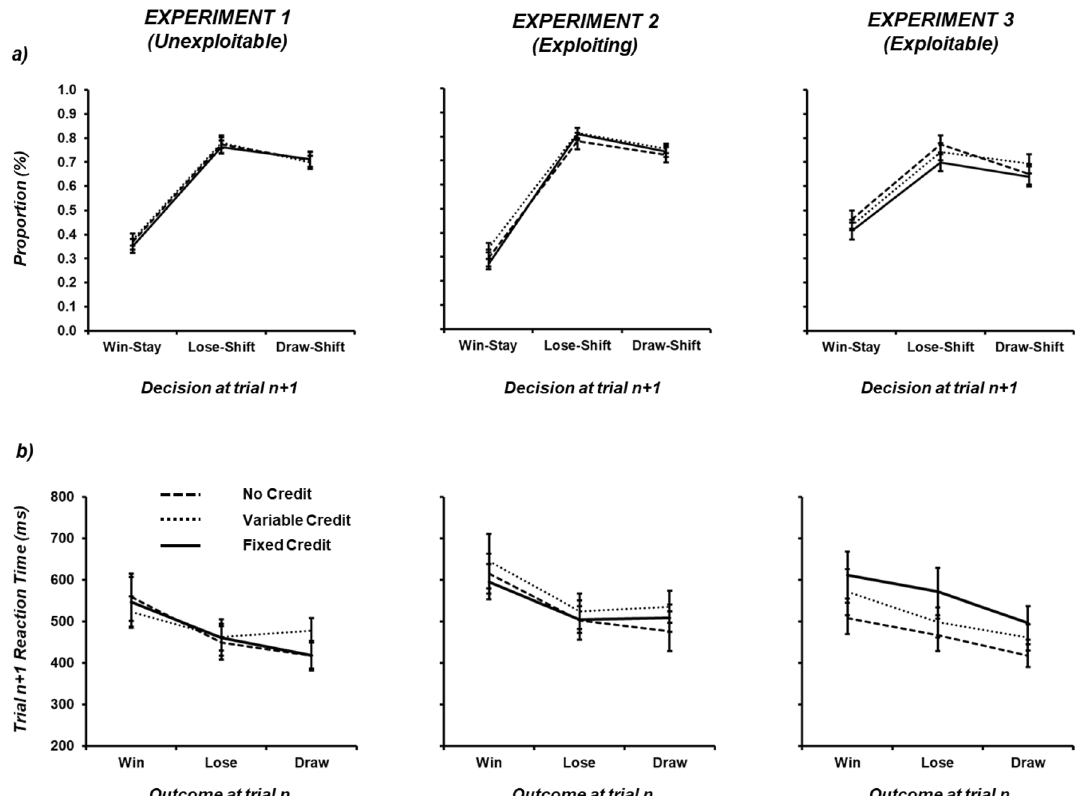
Figure 1. ( a ) Graph showing proportion of reinforcement learning biases (win-stay, lose-shift, draw- shift) under conditions of no, variable and fixed credit across three different opponent styles (Experiment 1 = unexploitable , Experiment 2 = exploiting , Experiments 3 = exploitable ). ( b ) Graph showing reaction times at trial n + 1 separated by outcome at trial n (win, lose, draw) under conditions of no, variable and fixed credit across three different opponent styles. In both ( a , b ) error bars indicate ± 1 standard error.